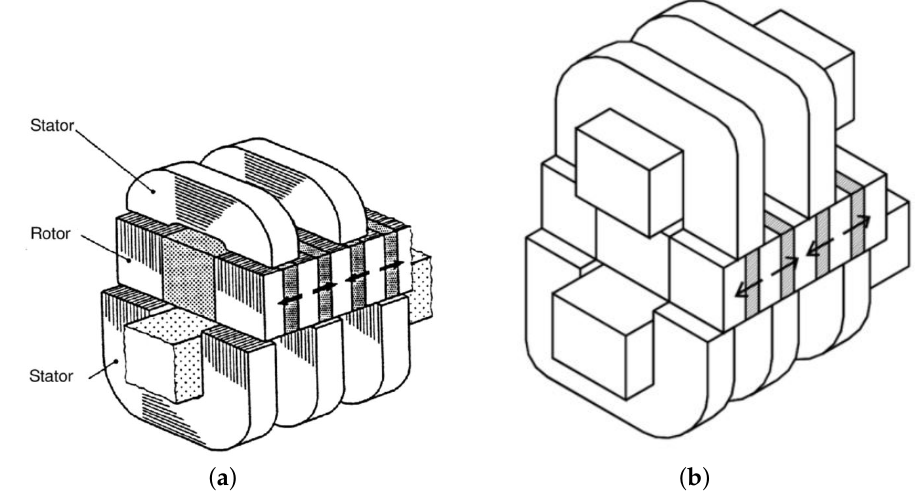
Figure 16. U-Core flux-concentrating transverse flux permanent magnet synchronous generators topologies [108]. ( a ) Double-sided single-winding. ( b ) Double-sided